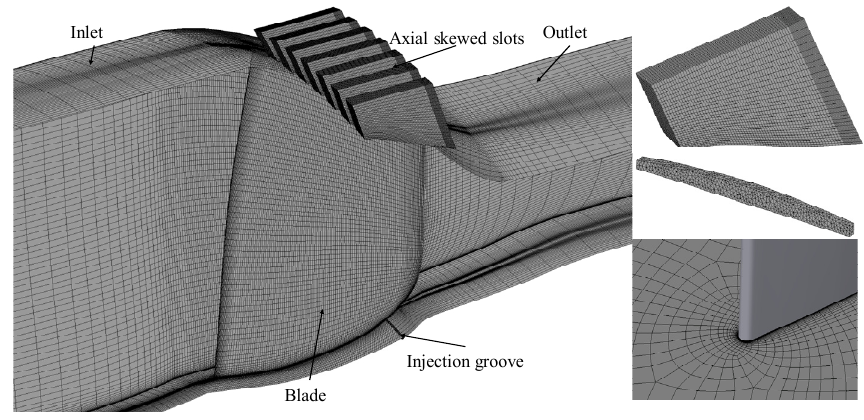
Figure 3. Computational domain and grids.